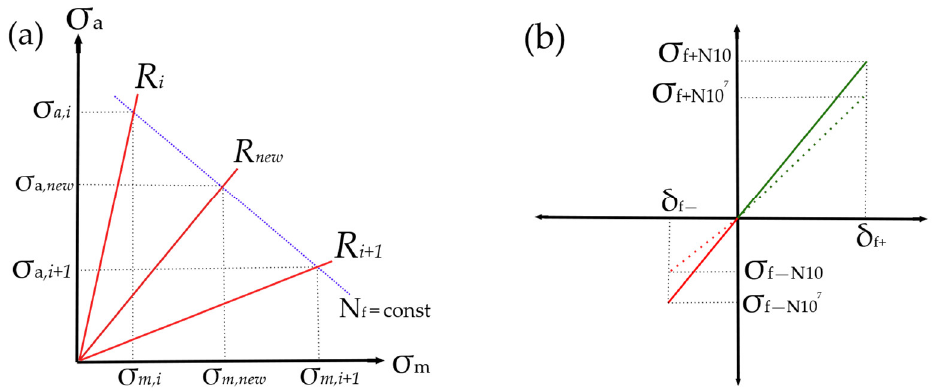
Figure 4. Assumptions accepted: ( a ) Linear interpolation between S-N curves for a predefined R-ratios; ( b ) Proportional to stress stiffness reduction.